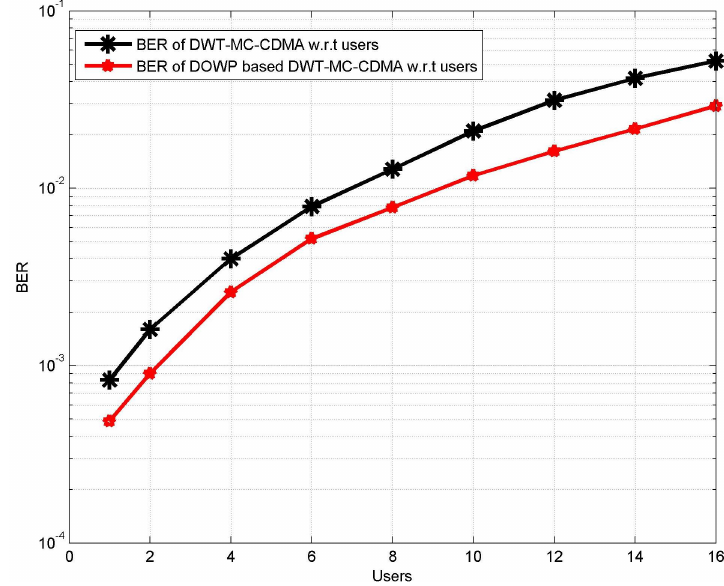
Figure 13. BER versus number of